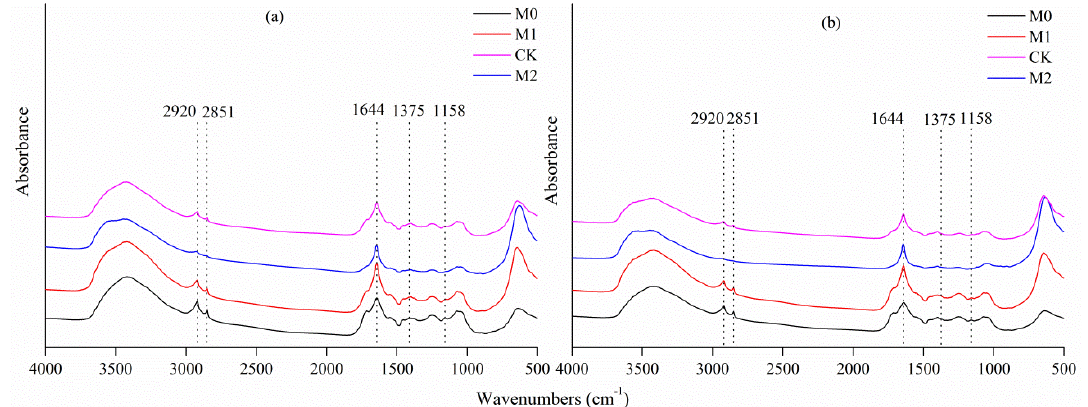
Figure 1. MBC (microbial biomass C) and DOC (dissolved organic C) contents ( a , b ), and the ratio of MBC to TOC (total organic C) and that of DOC to TOC ( c , d ) in the soil of the different studied forests.